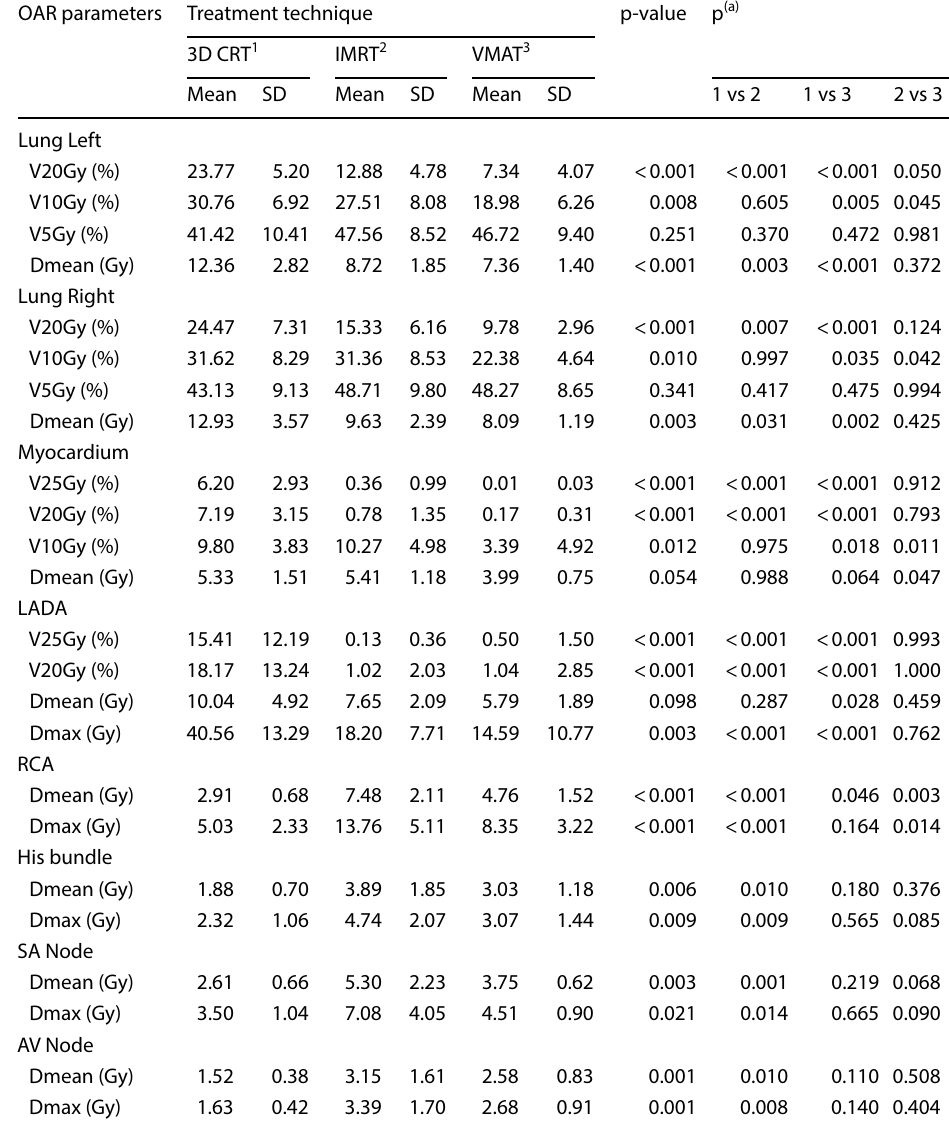
Table 3 Comparison of the dose absorbed by at-risk organs under irradiation using 3D CRT (1), IMRT (2), and VMAT (3)